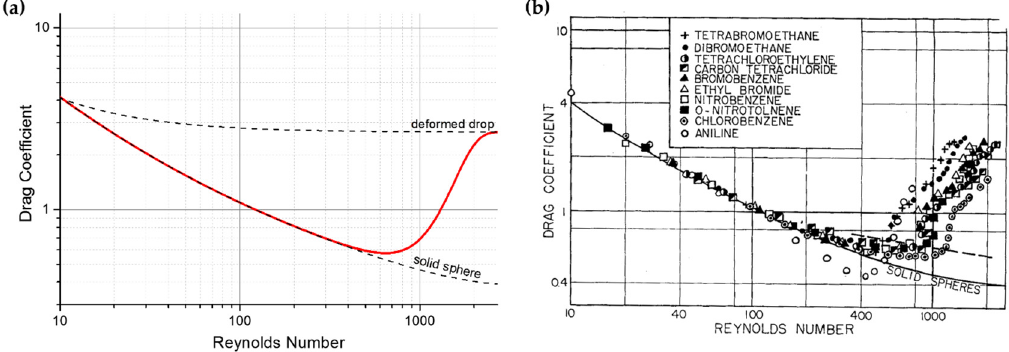
Figure 3. Comparison of the proposed drag curve ( a ) and the experimental data of Hu and Kintner ( b ), reproduced from reference [29] with permission.